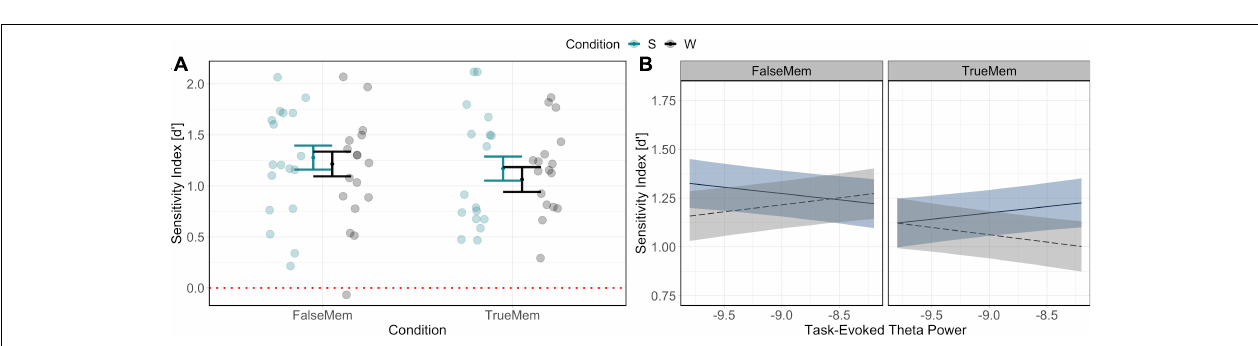
FIGURE 3 | Theta power differences plotted by scalp region of interest for laterality. Significant effects of condition by laterality are driven by differences between midline vs. other locations.